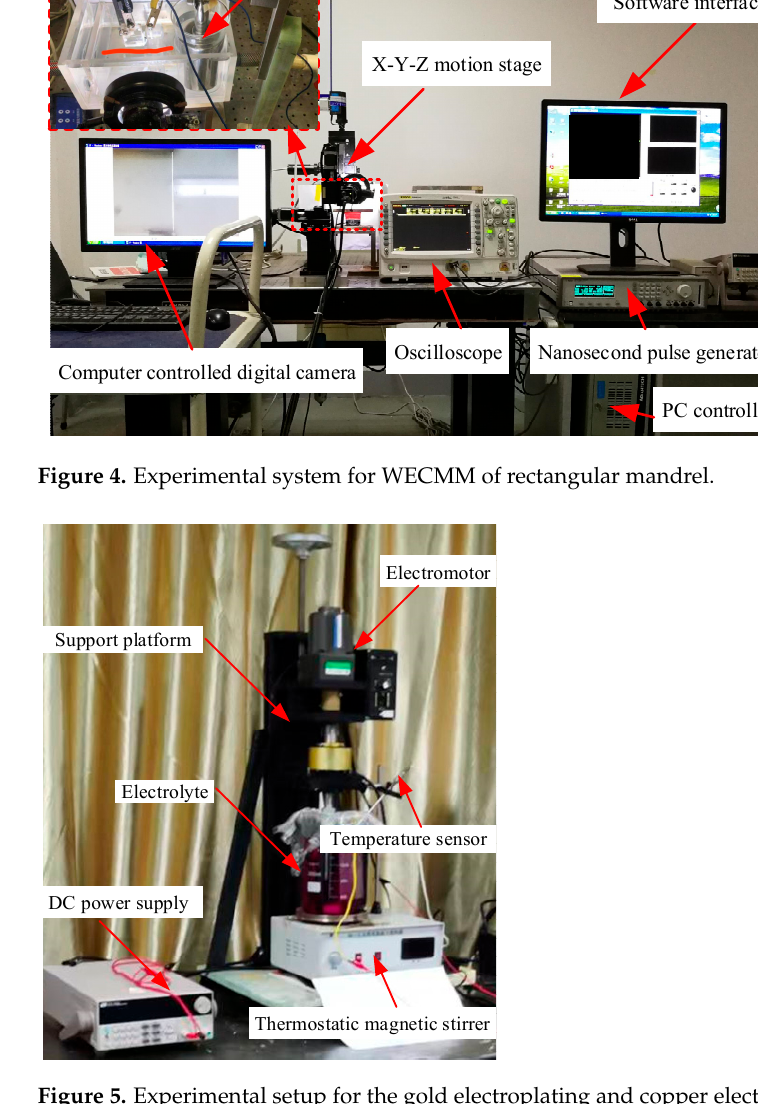
Table 3. The selected parameter combination for WECMM of pure aluminum rectangular mandrel. Parameter